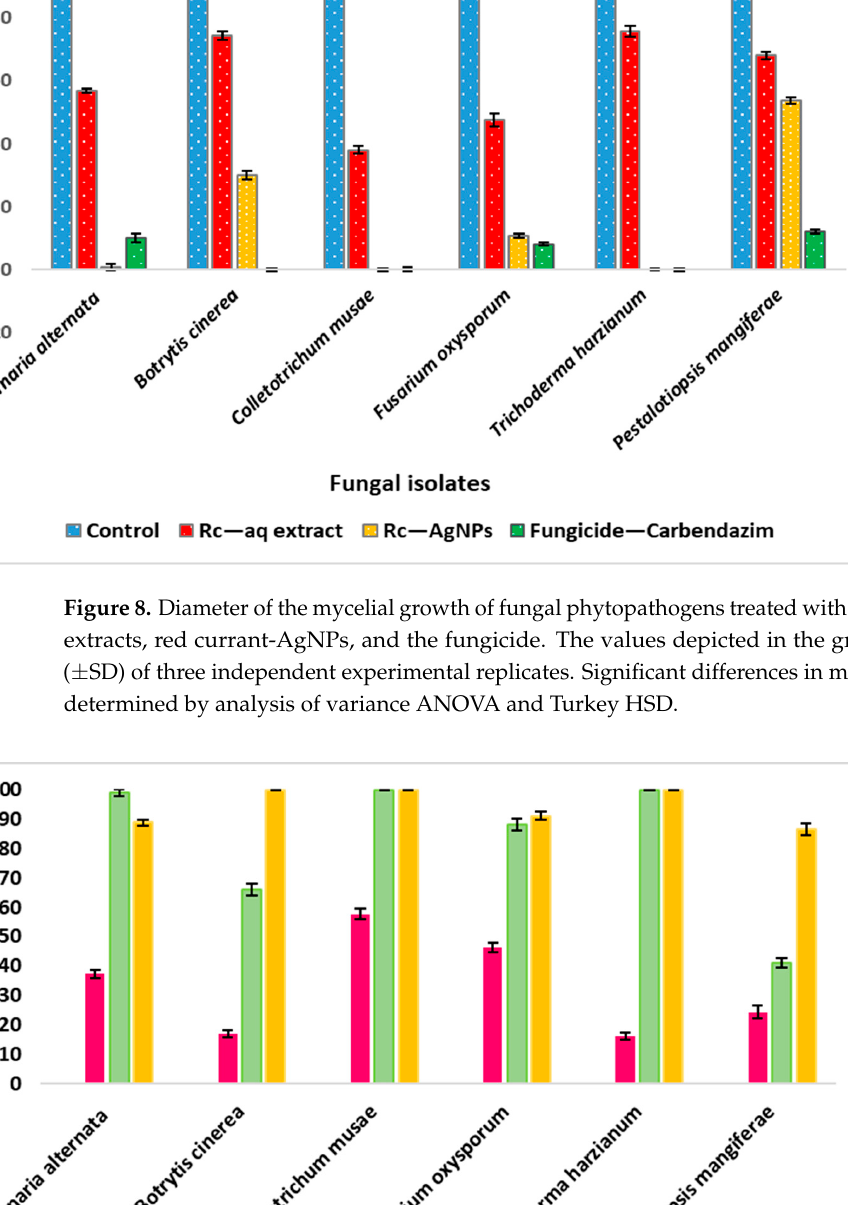
Figure 9. Percentage of mycelial growth inhibition of some fungal phytopathogens treated with red currant aqueous extracts, red currant-AgNPs, and the fungicide carbendazim (2%). The values dis- played in the above graph are means of triplicate experimental replicates (±SD). Significant differ- ences in means ( p ≤ 0.05) were determined by analysis of variance ANOVA and Turkey HSD.